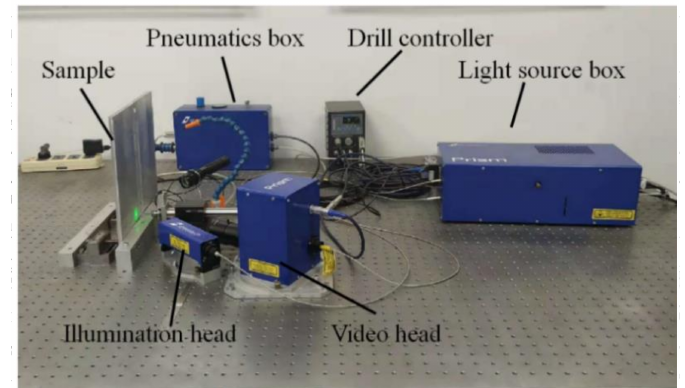
Figure 4. Residual stress test setup.